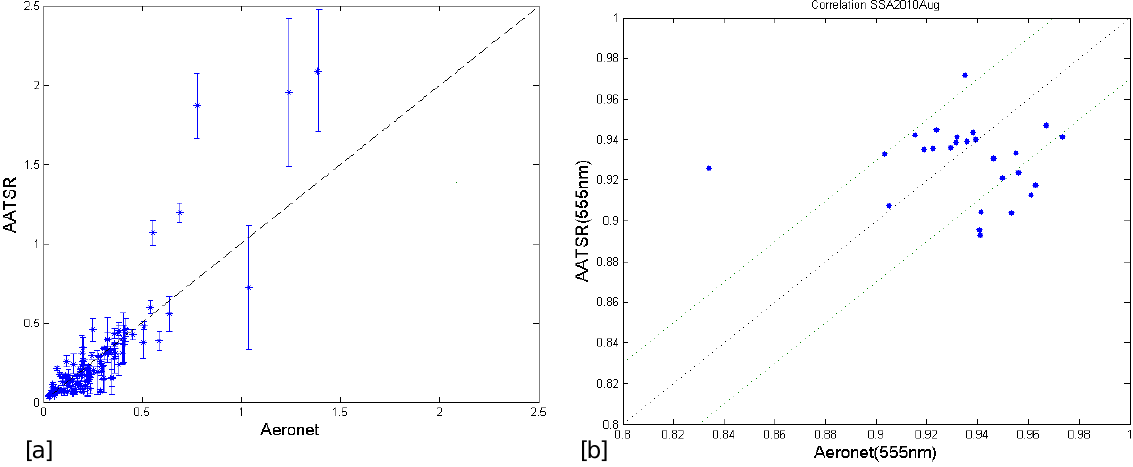
Figure 5. Comparison of AOD (a) and SSA (b) at 0.555µm retrieved from AATSR and AERONET.